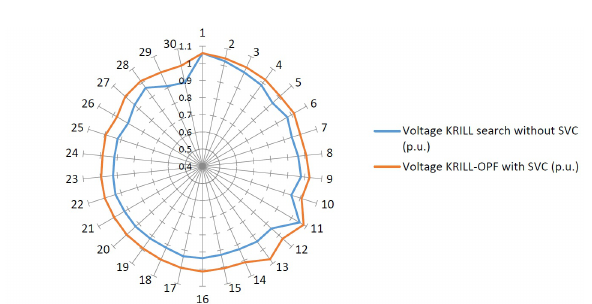
Figure 4: Objective Function value with the Variation of Krill Herd Parameters *NR= NO OF RUNS NK=NO OF KRILLS